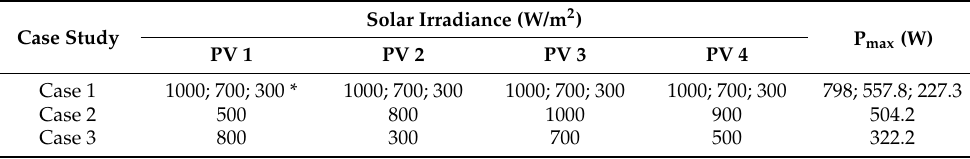
Table 3. PV panels configuration and insolation